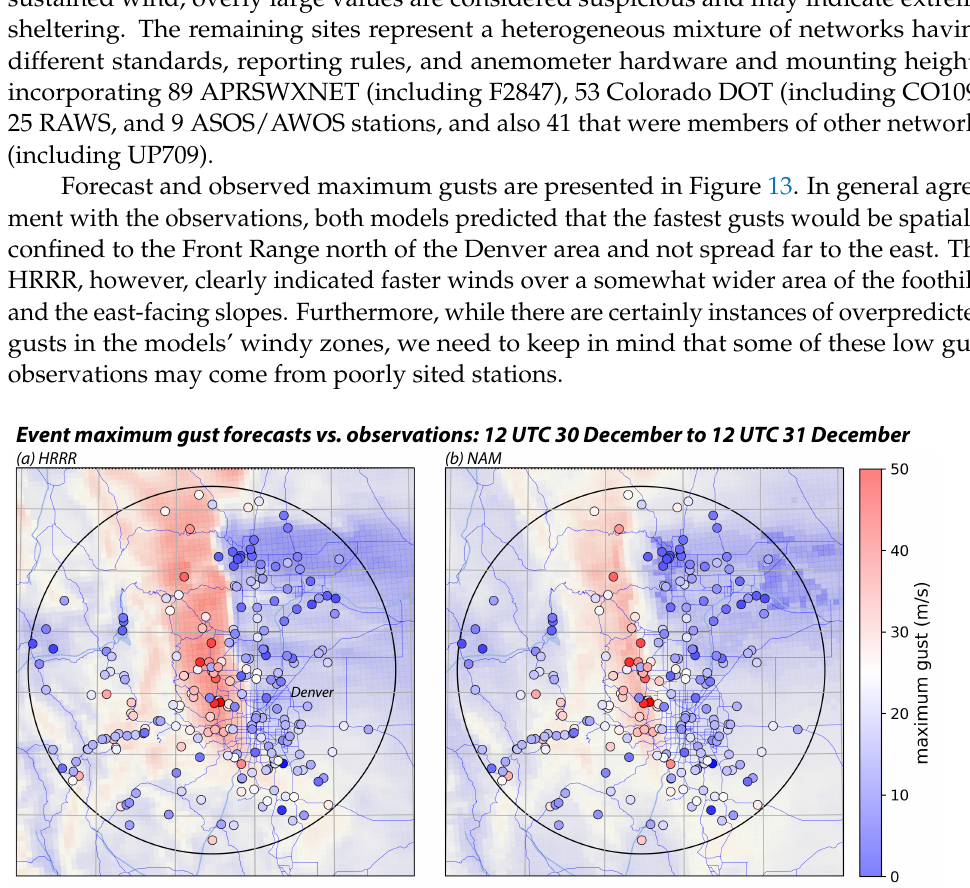
Figure 13. Event maximum gust forecasts (shaded, m/s) from the 1200 UTC 30 December 2021 ( a ) HRRR and ( b ) NAM cycles, compared to observed gust maxima for stations within 100 km of Boulder (indicated by the black circle). Comparison limited to a 24 h period spanning the windstorm. See text for filtering employed for